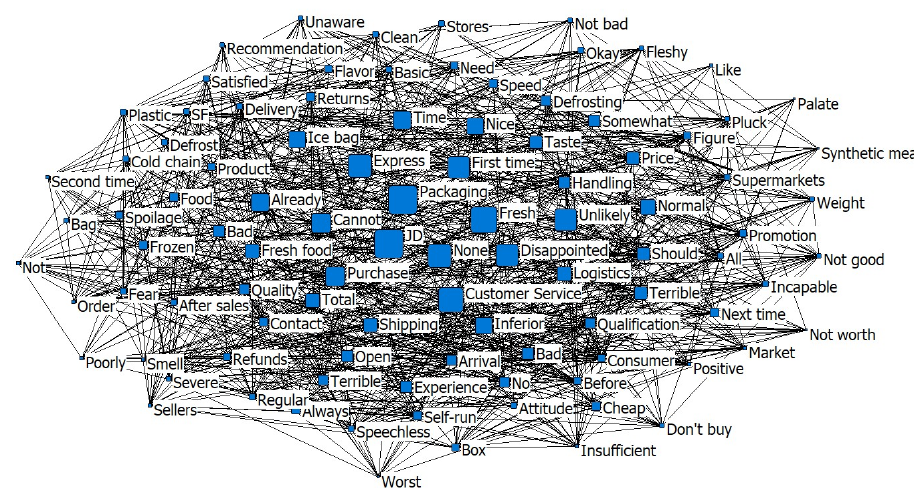
Figure 9. Analysis of betweenness centrality.